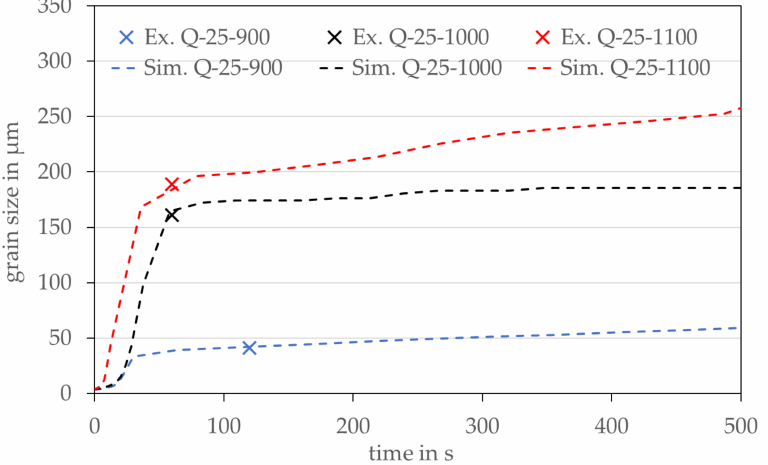
Figure 10. Simulated recrystallization and grain growth kinetics (dashed lines) based on grain size (y- axis) and time (x-axis) compared to individual experimental results (crosses). Data for experimental results are taken from [38].